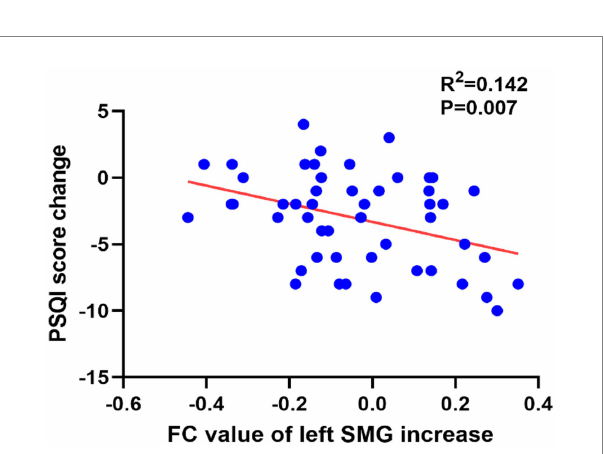
FIGURE 4 Analysis of the correlation between the FC changes and PSQI improvement in all subjects.